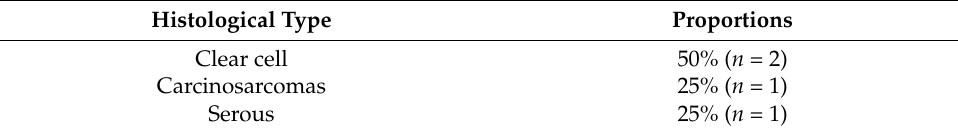
Table 8. Amplified HER2 gene cases according to their histological